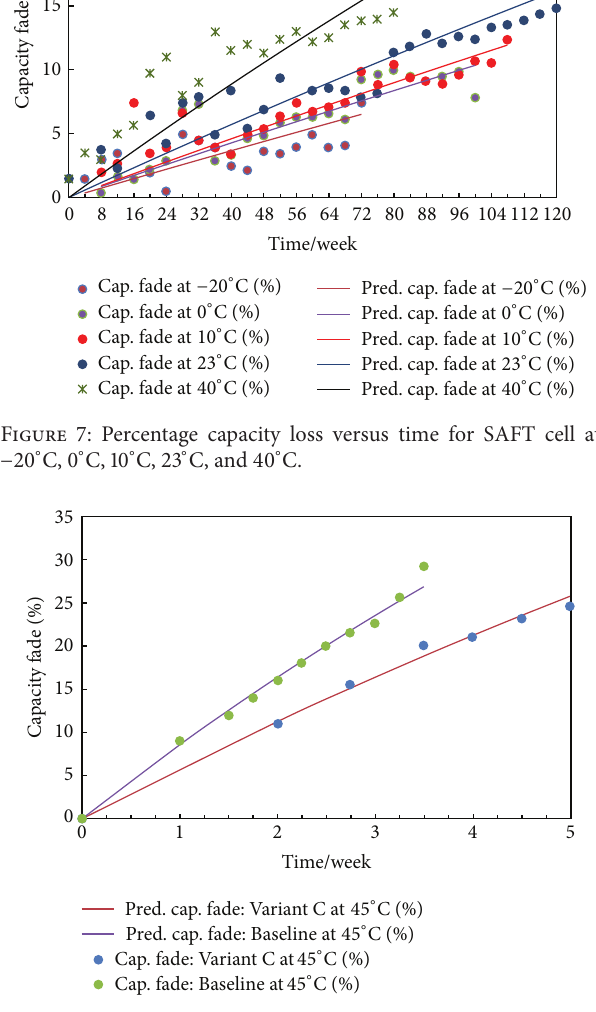
Figure 8: Percentage capacity loss versus time for ATD Gen 2 Baseline cell and Gen 2 Variant C cell at 45 ∘